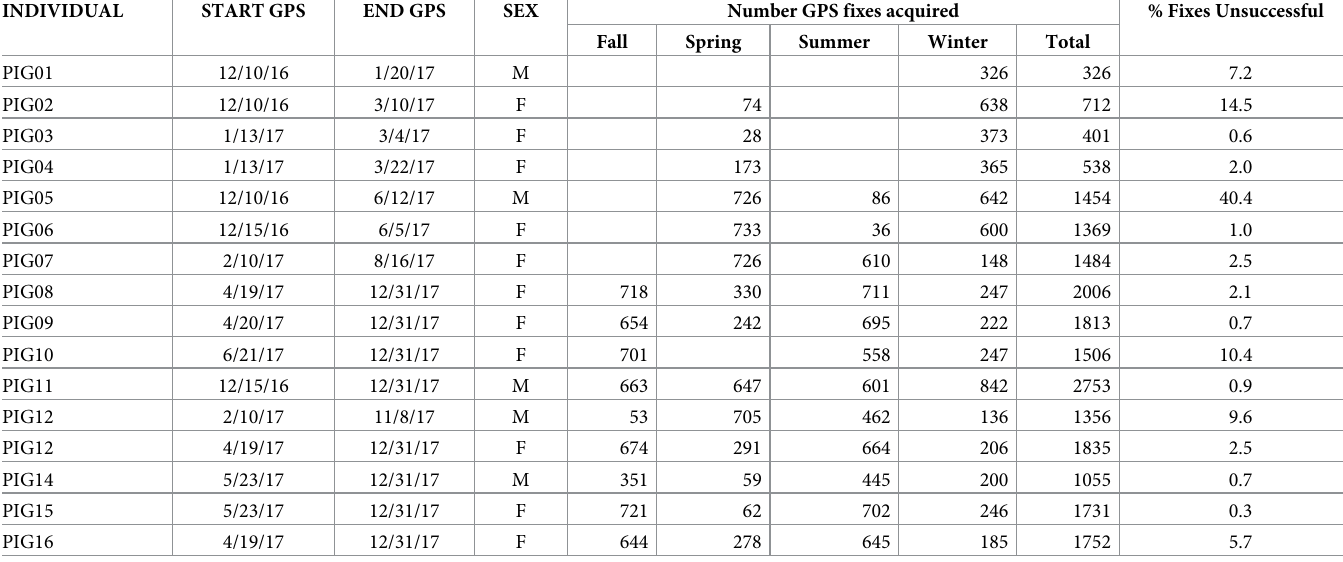
Table 1. Timeline for each pig equipped with a GPS collar. Number of GPS locations acquired for each pig were tallied by season on Fort Hood Military Installation 2016–2017. INDIVIDUAL START